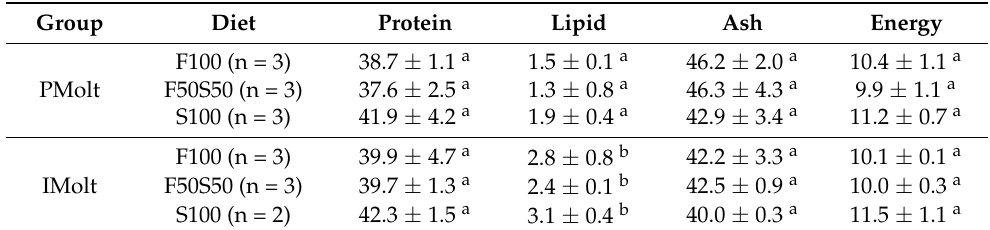
Table 3. Crab body proximal composition (%) and energy content (kJ · g − 1 of dry body weight) on dry weight basis in PMolt and IMolt crab groups fed ad libitum.